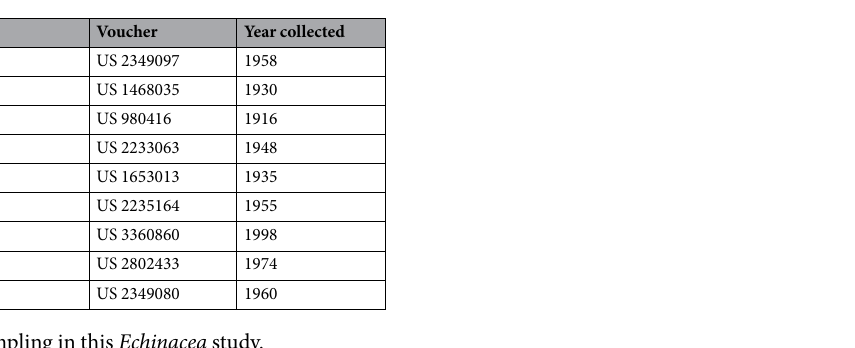
Table 5. Sampling in this Echinacea